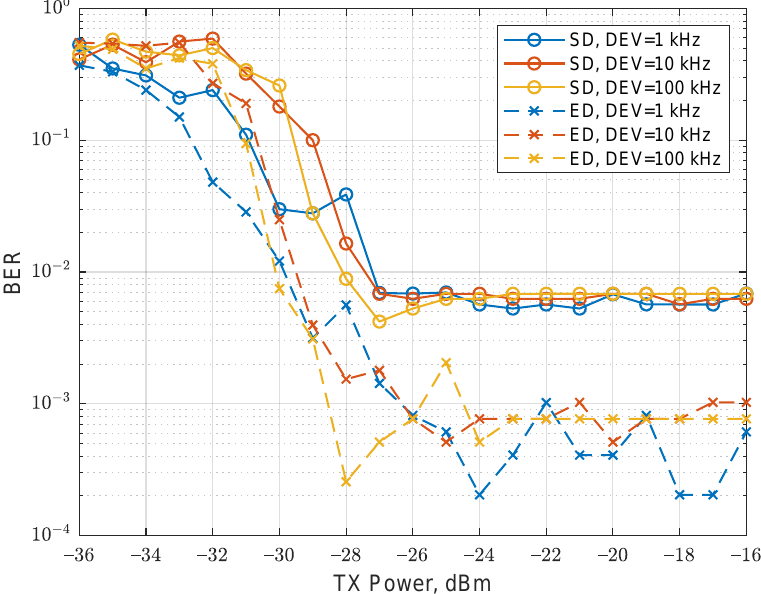
Figure 12. BER versus transmit power in dBm with different bit detectors in a single model scenario.